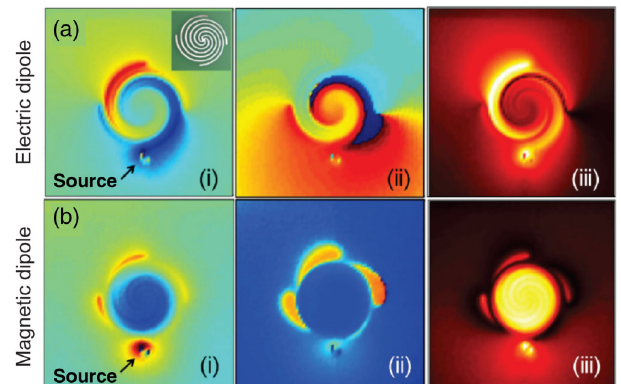
FIG. 4. Measured near-field distribution of the LSP. Measured near-field distributions of (a) the electric dipole LSP at 1.1 GHz and (b) the magnetic dipole LSP at 1.87 GHz for the ultrathin metallic structure. Panels (i), (ii), and (iii) show the transient fields, phases, and magnitudes, respectively. The inset of panel (i) of (a) shows a photograph of the fabricated